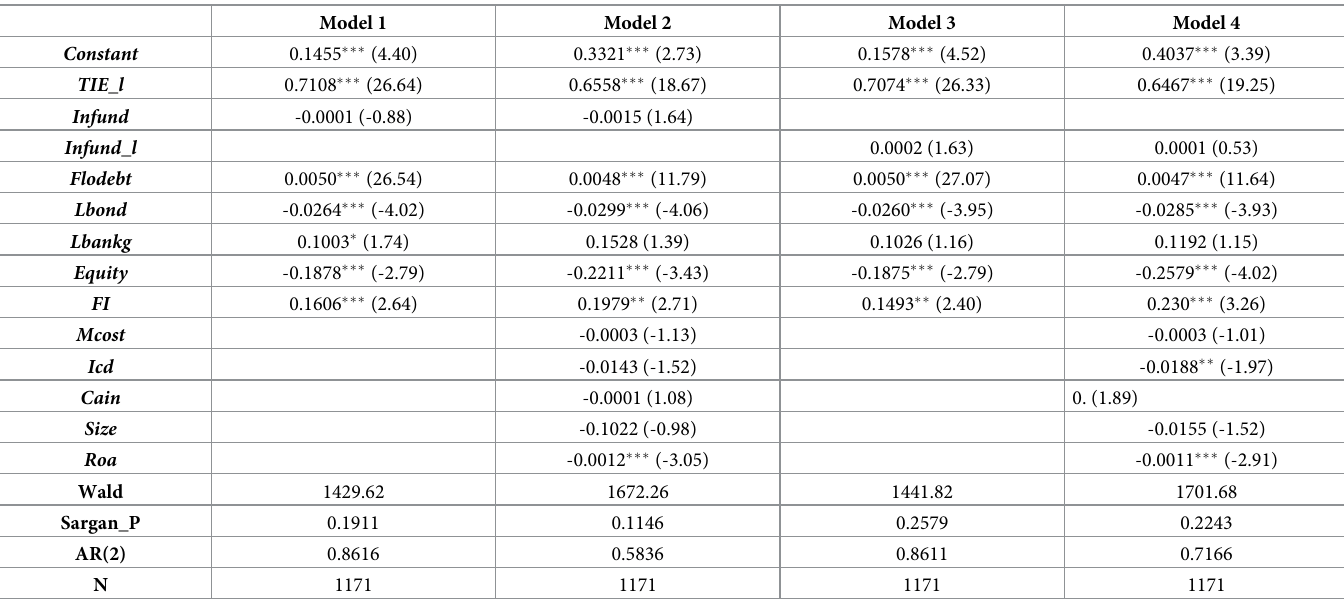
Table 9. Results of the SYS-GMM estimation method.